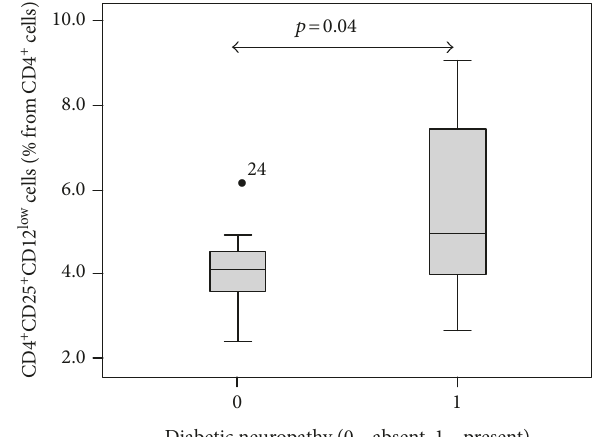
Figure 5: The presence of diabetic neuropathy and CD127 low Treg cells. Patients su ff ering from diabetic neuropathy showed a signi fi cantly higher number of CD127 low Treg cells than patients with no